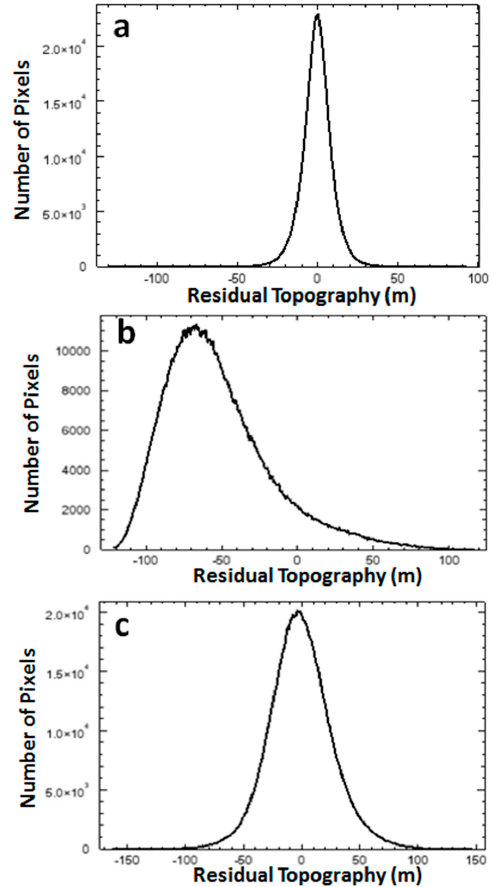
Figure 9. Statistic of the estimated residual topography: ( a ) using 0 wavelet numbers for the ALOS/PRISM DEM, where the average residual topography becomes almost 0 m and the standard deviation is significantly reduced and equal to 9.5 m; ( b ) using 0 wavelet for the SRTM DEM, where the average residual topography becomes − 52.5 m and standard deviation equal to 35.1 m; and ( c ) using wavelet number equal to 2 for the SRTM, where the average residual topography becomes − 1.5 m and high standard deviation equal to 25.03 m.